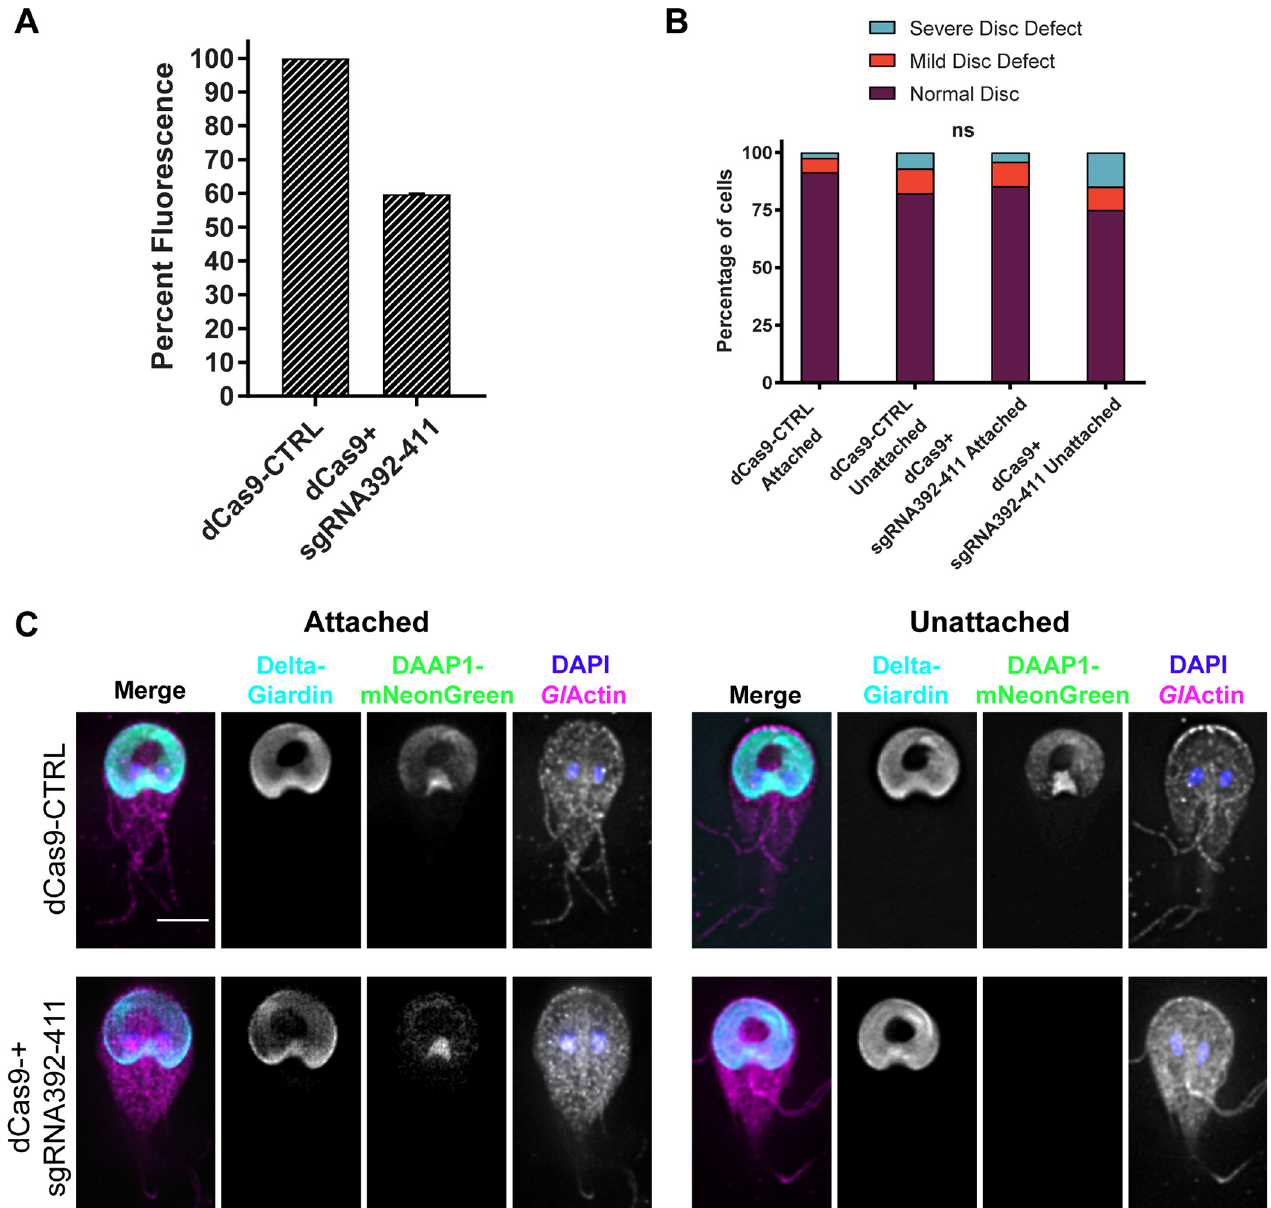
Fig 5. DAAP1-depleted discs do not have defects detectable by light microscopy. A) Fluorescence of DAAP1-mNeonGreen cells transfected with a dead Cas9 vector containing a HALO-tagged delta-giardin and either a non-specific small guide RNA (dCas9-CTRL) or a small guide RNA targeting DAAP1 (dCas9 +sgRNA392-411). Normalized to the control, the DAAP1-depleted cells demonstrated a population-average knockdown of 40% ± 3 (three independent transformations). B) Attached and unattached control and DAAP1-depleted cells were fixed and stained separately before assessing their disc morphology. Based on a chi-square test, there was no significant difference in disc defects observed between either attached or unattached groups. (Control attached N = 129 cells, control unattached N = 126, DAAP1-depleted attached N = 123, DAAP1-depleted unattached N = 128.) Attached cells, P = 0.3483. Unattached cells:, P = 0.1288. C) Representative images from B: Gl Actin (magenta), delta-giardin-HALO (cyan), DAAP1-mNeonGreen (green), and DAPI/nuclei (blue). Scale bar denotes 5 μ